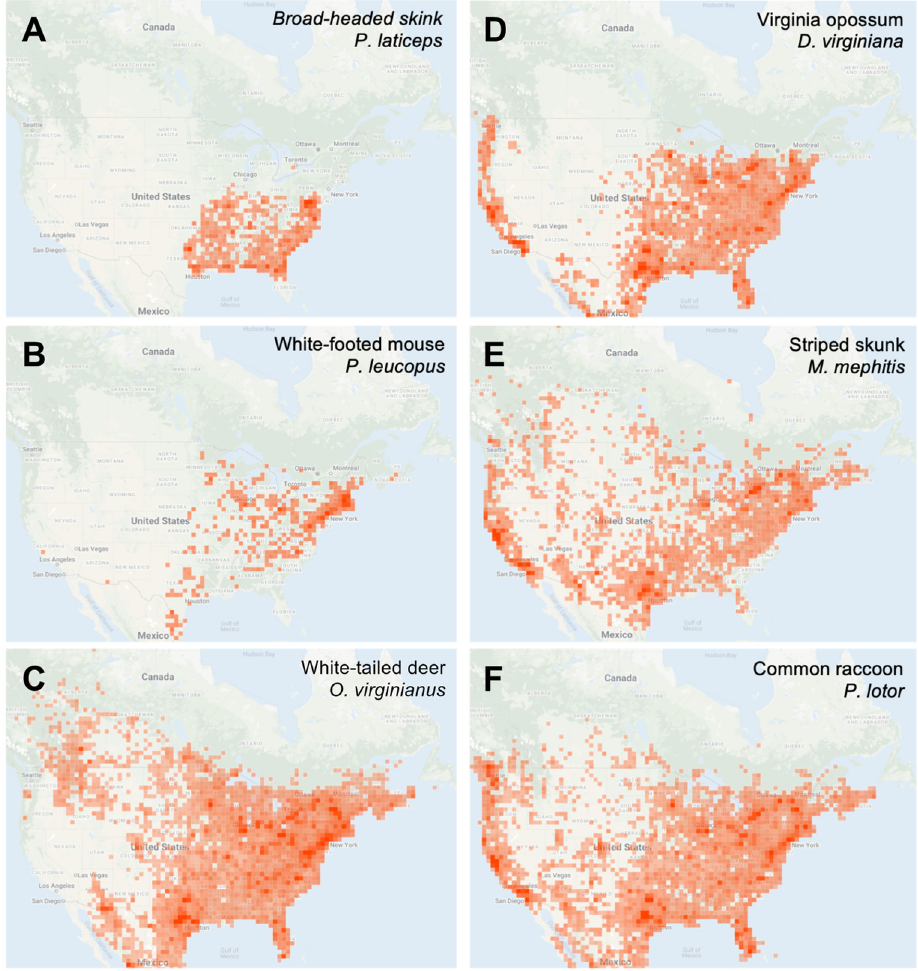
Figure 5. Distribution of iNaturalist research grade observations of various small, medium, and large animal hosts of ticks: ( A ) Plestiodon laticeps; ( B ) Peromyscus leucopus; ( C ) Odocoileus virginianus; large animal hosts of ticks: ( A ) Plestiodon laticeps ; ( B ) Peromyscus leucopus ; ( C ) Odocoileus virginianus ; ( D ) Didelphis virginiana; ( E ) Mephitis mephitis; ( F ) Procyon lotor. Map data Copyright 2022 Google, ( D ) Didelphis virginiana ; ( E ) Mephitis mephitis ; ( F ) Procyon lotor . Map data Copyright 2022 Google, INEGI.